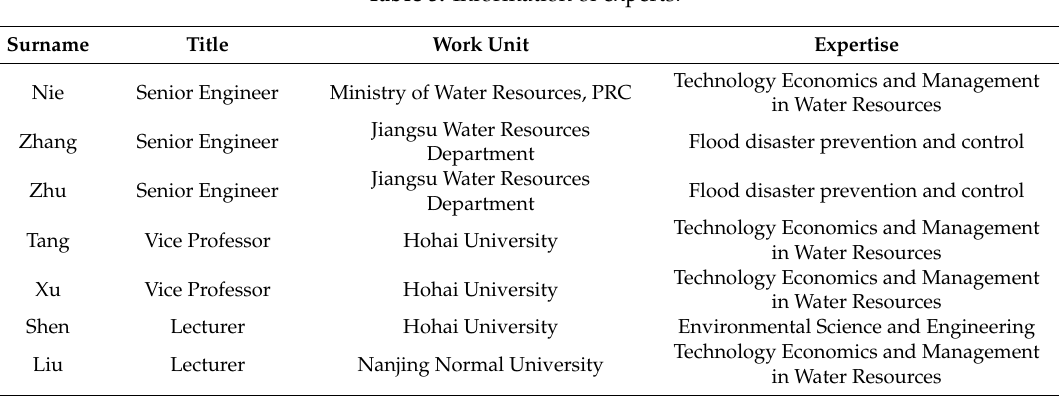
Table 5. Information of